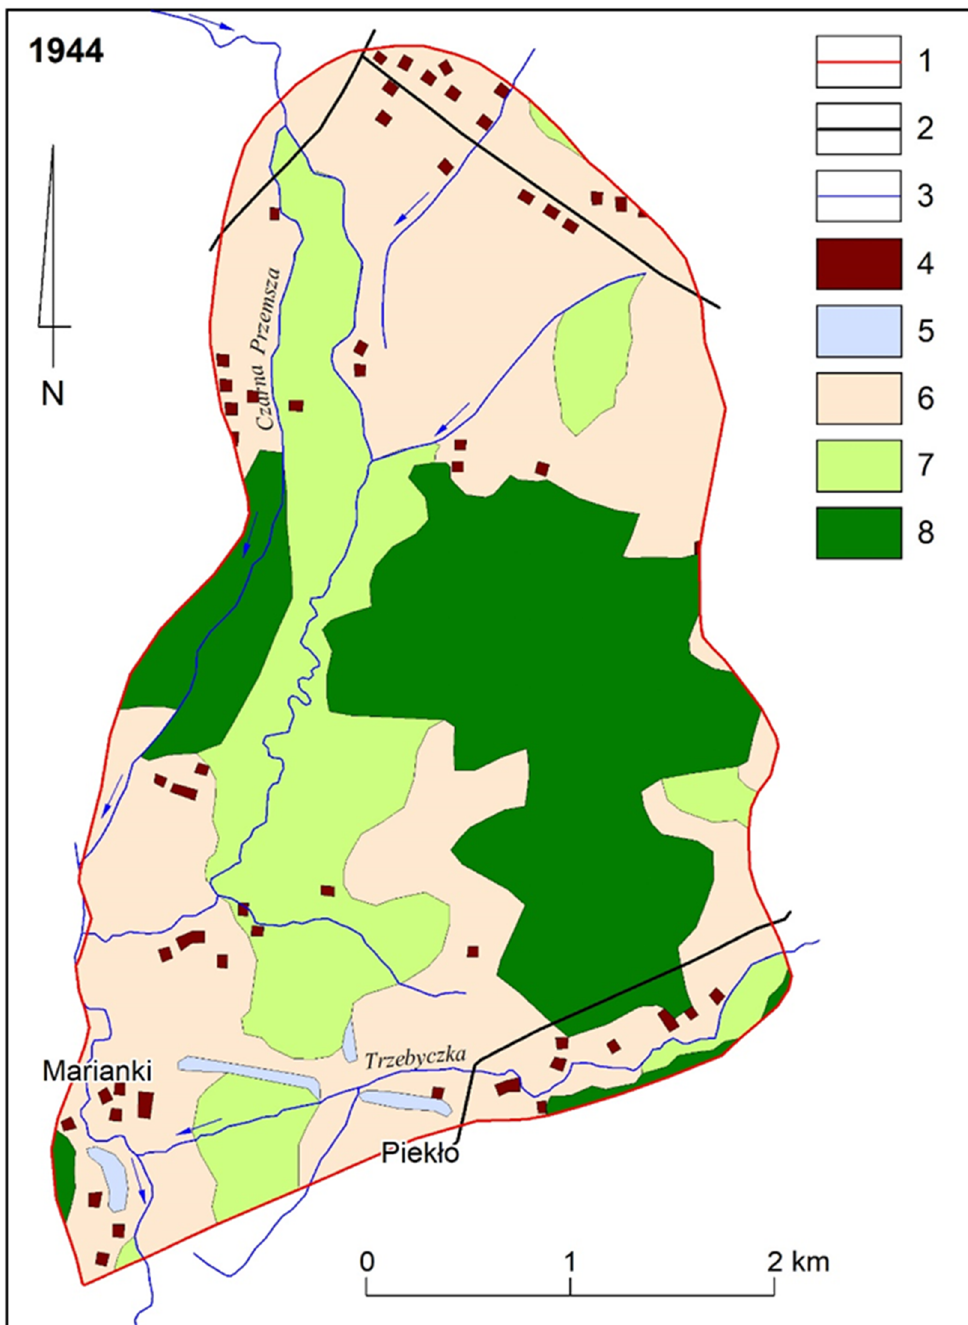
Figure 2 . Changes in land use in the area of Ku ź nica War ęż y ń ska for the year 1944: 1—border of the Figure 2. Changes in land use in the area of Ku´znica War˛e˙zy´nska for the year 1944: 1—border of